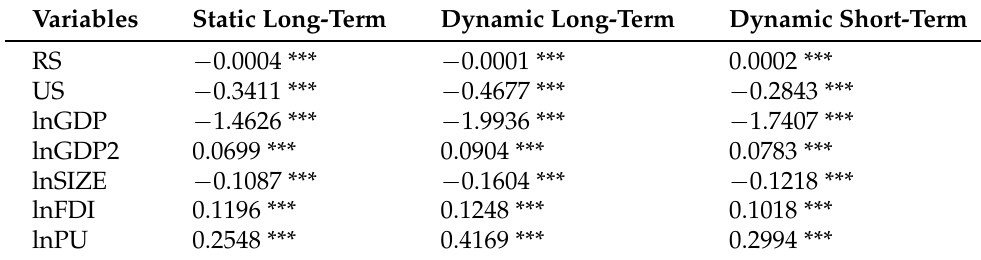
Table 11. Spatial direct effect.